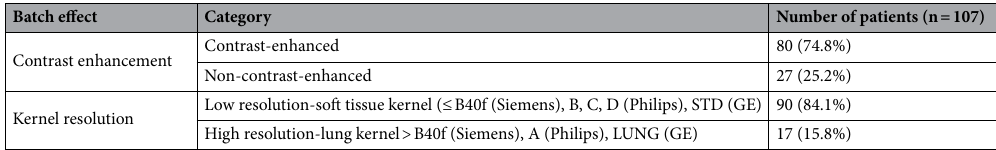
Table 1. Batch effects introduced by image acquisition